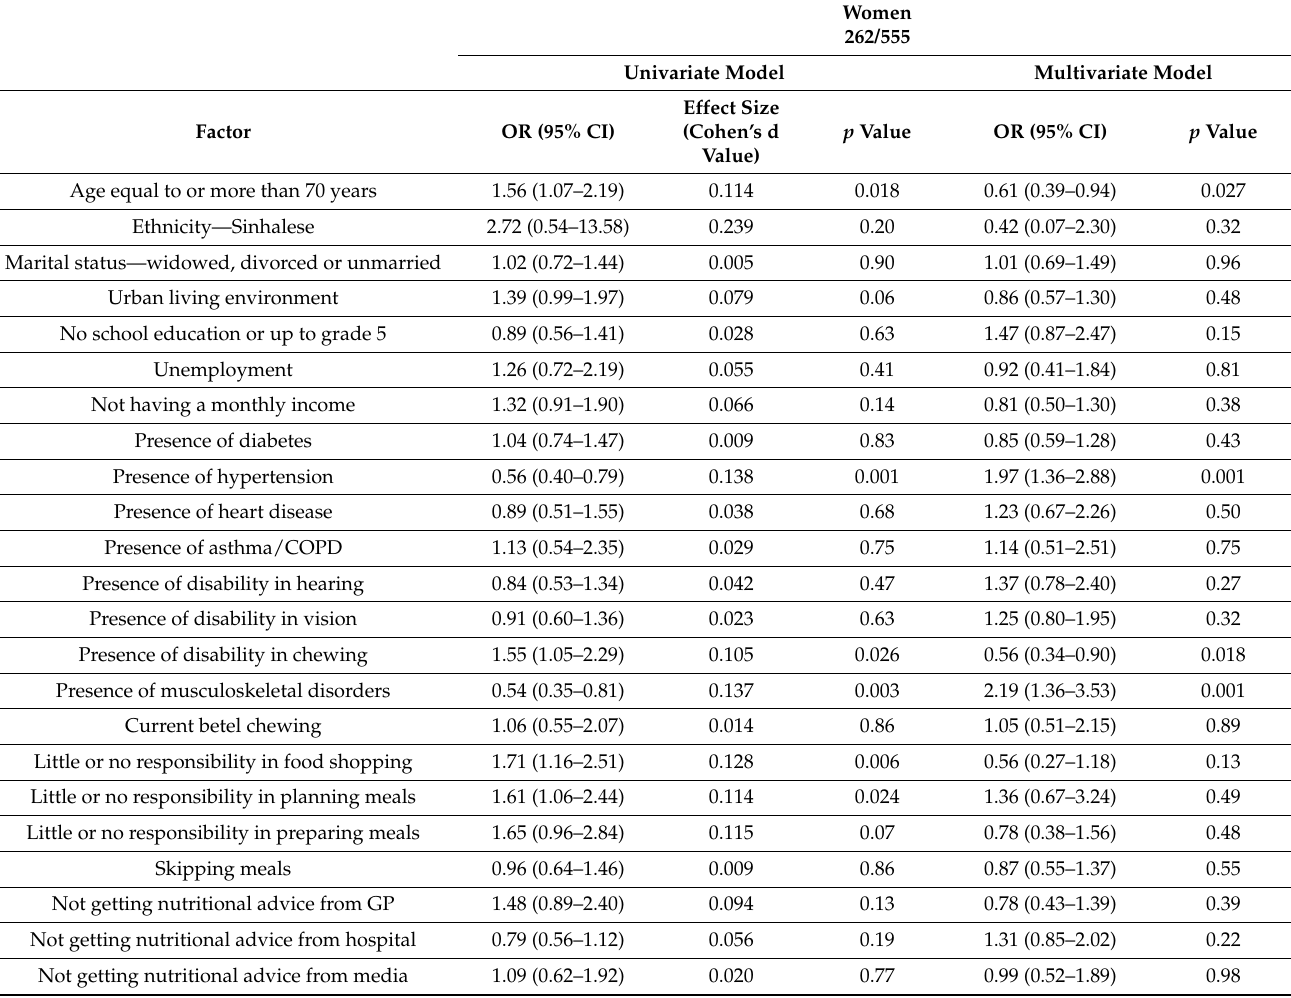
Table 2. Univariate and multivariate regression analysis of associated factors, odds ratios and their likelihood for undernutrition among older